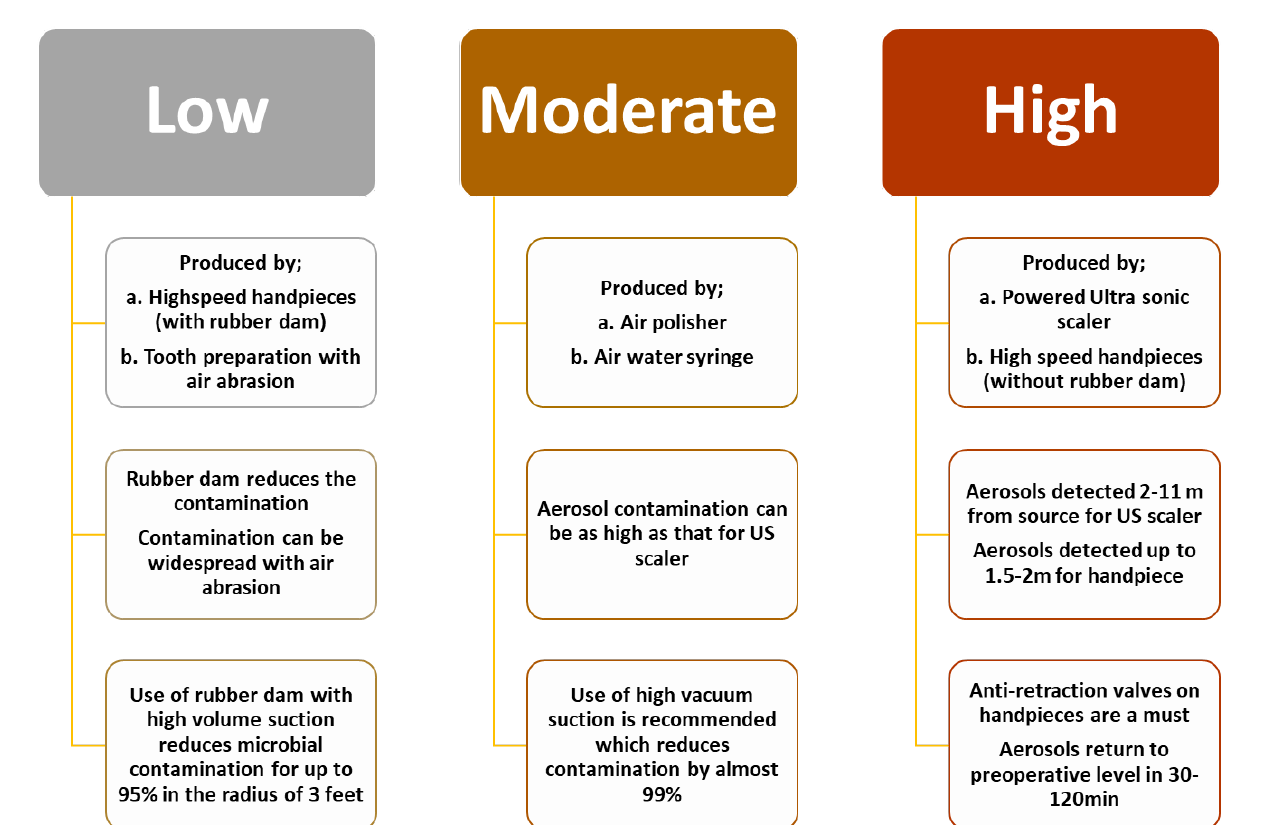
Figure 7. Aerosol-generating dental procedures and associated factors [135] .